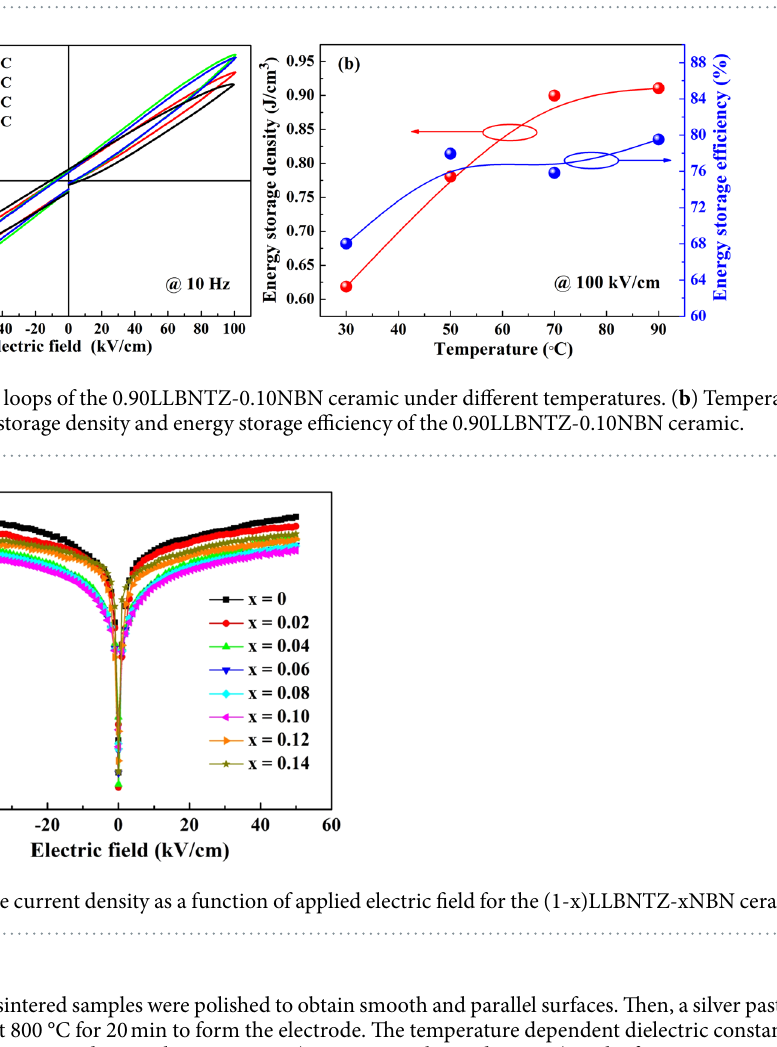
9 SciEnTific REPORTs | 7: 8726 | DOI:10.1038/s41598-017-06966-7